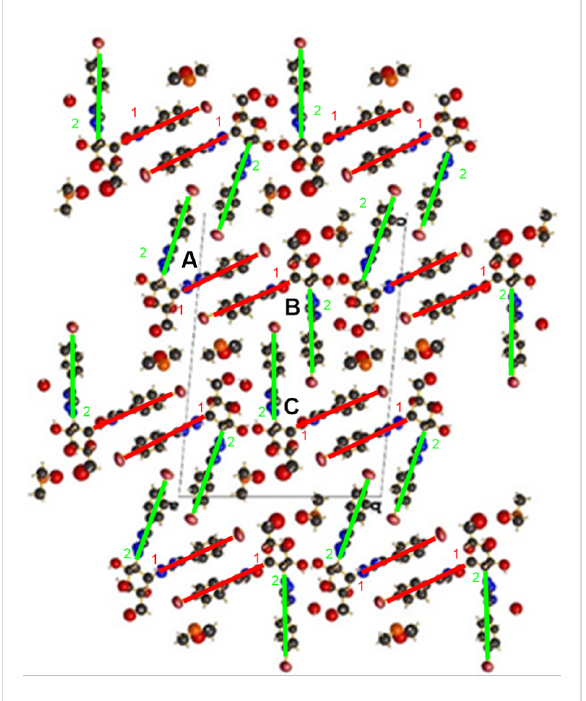
Figure 5: Crystal packing of 10 ( cis configuration) in DMSO/H 2 O (1:1, v/v). Colored lines: π – π stacking interactions between phenyltriazoles in positions 1 (red lines) and 2 (green lines).